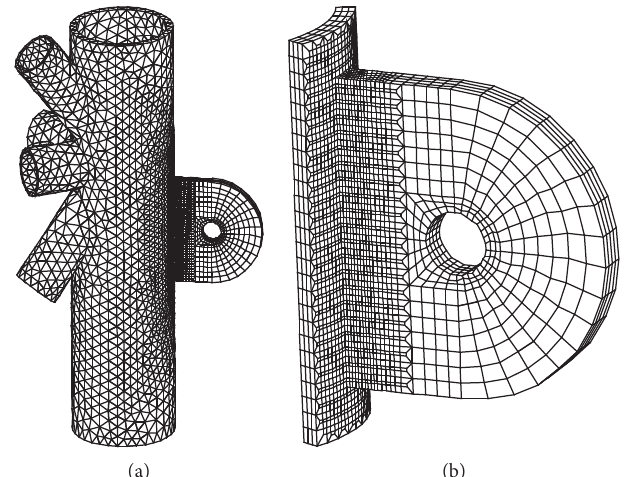
Figure 6: Refined mesh model for welded joints. (a) Finite element model of welded joints. (b) Details of the gusset plate and weld.